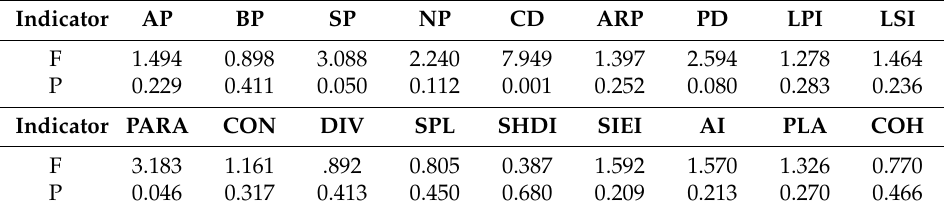
Table 3. Differences in forest color patches over three months.